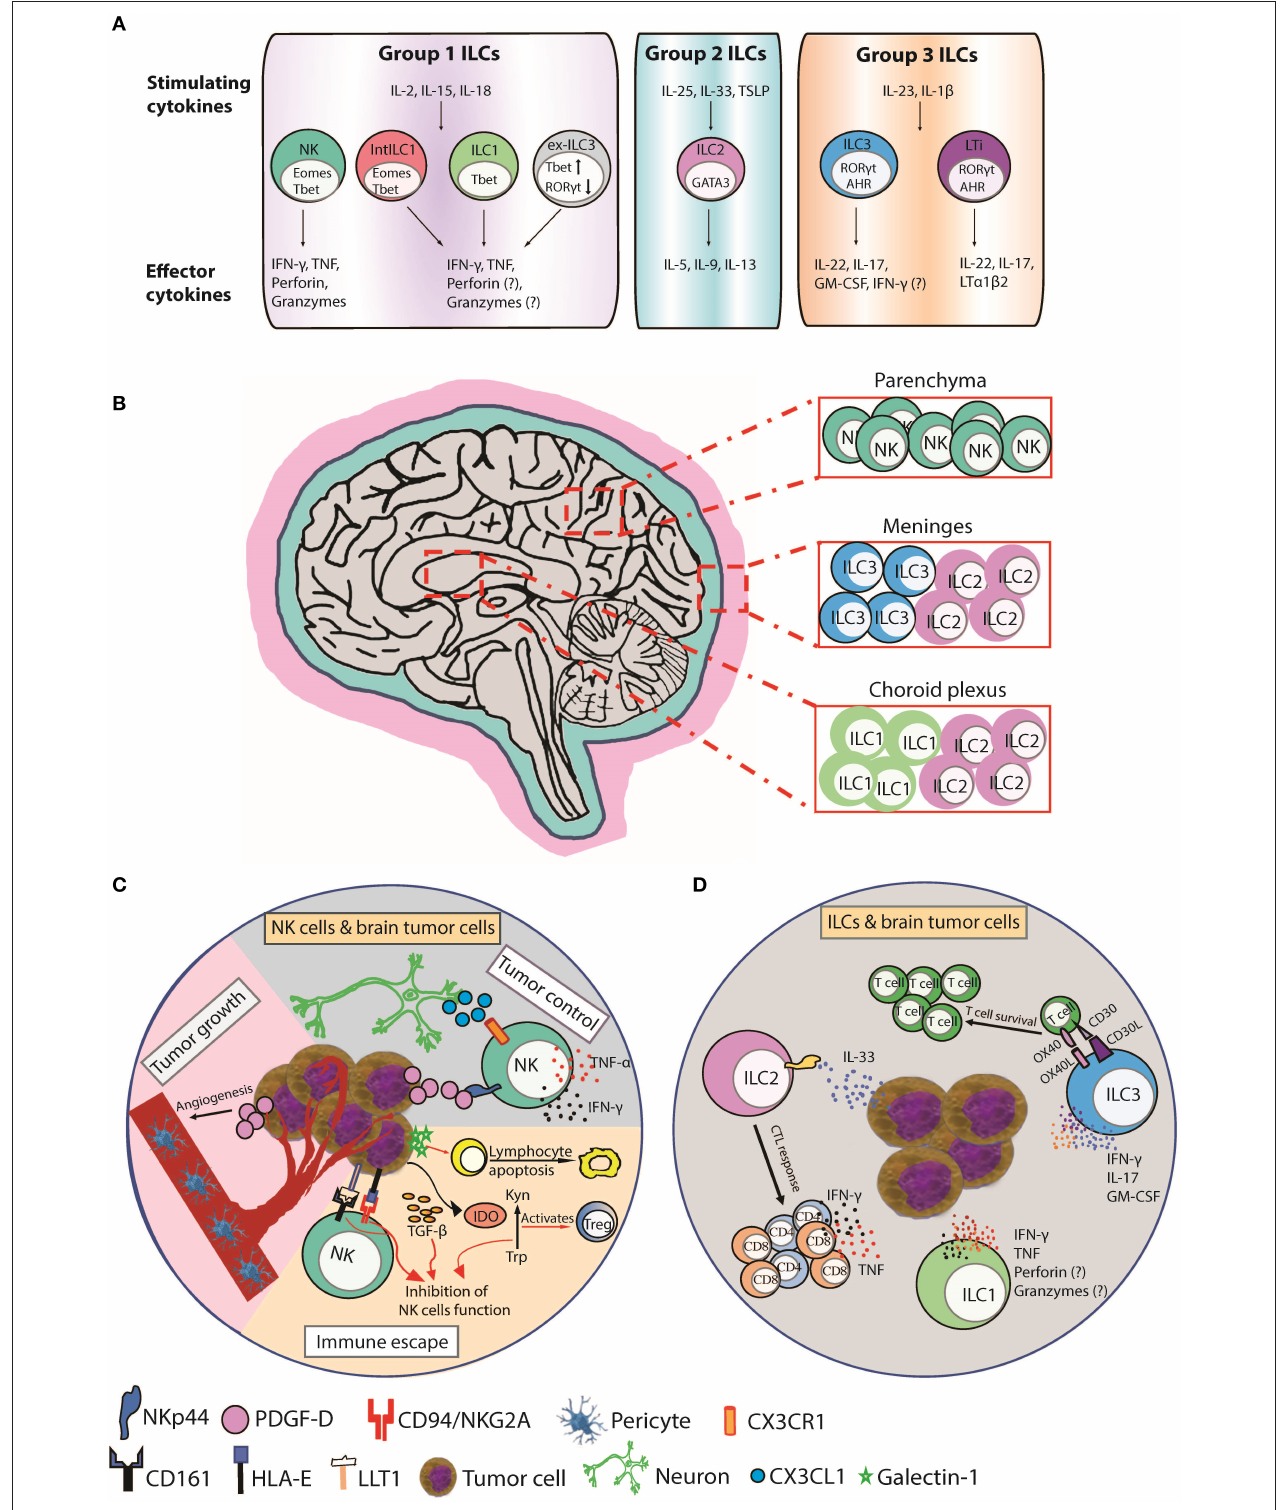
FIGURE 1 | Function, distribution, and anti-tumor responses of CNS ILC subsets. (A) Group 1 CNS ILCs have thus far been shown to include NK cells, intermediate ILC1s (intILC1s), ILC1s, and “ex-ILC3s.” NK cells express T-bet and Eomes and secrete IFN- γ and TNF in response to IL-2, IL-15, and IL-18, and lyse malignant cells